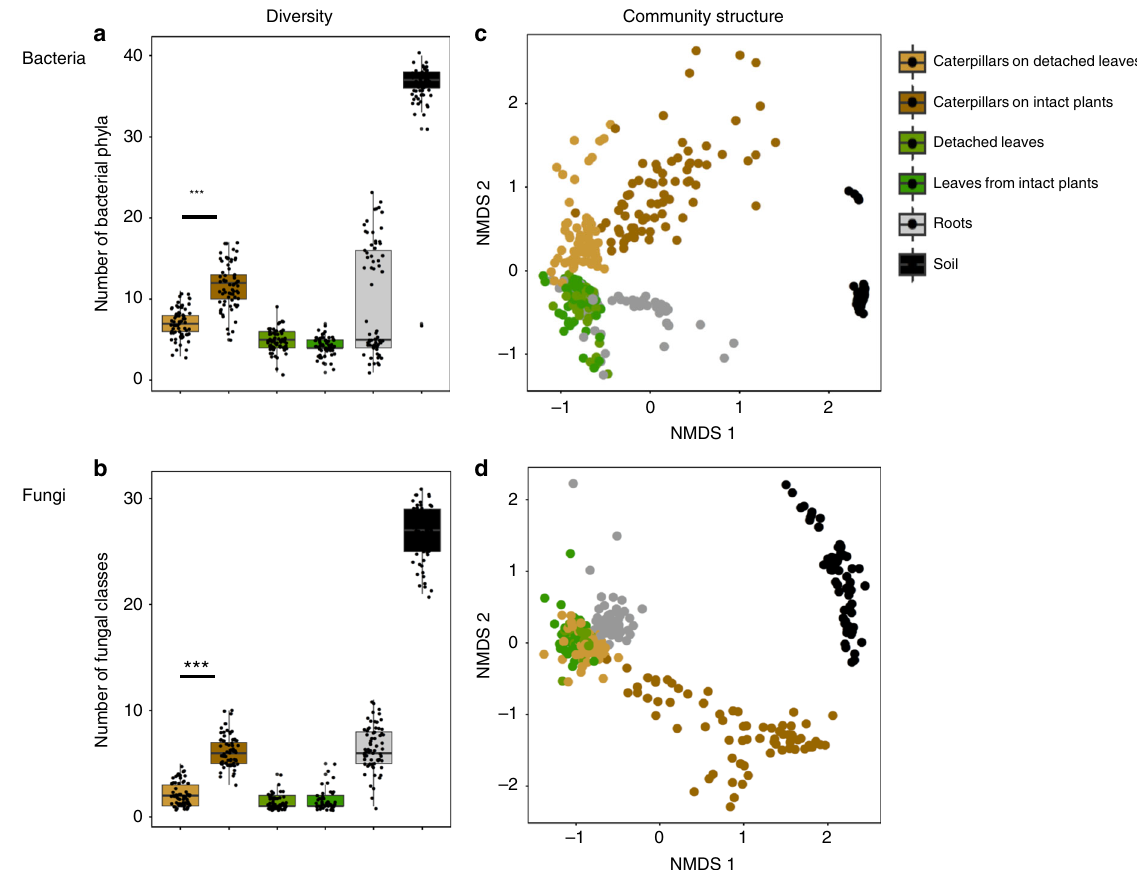
Fig. 1 Diversity and community structure of bacteria and fungi in caterpillars, leaves, roots and soil. a number of bacterial phyla and b number of fungal classes of caterpillar, leaf, root and soil samples. Caterpillars were kept on intact plants or on detached leaves. The Tukey box-and-whisker-plots depict median number of phyla and classes in each compartment and variation is shown in the scatter. The raw (Chao1) diversity data is presented in Supplementary Fig. 2, and phyla and their relative abundance in Supplementary Fig. 3 (bacteria) and Supplementary Fig. 4 (fungi). Asterisks (***) indicate signi fi cant differences of GLM at the level of p < 0.001. c , d Non-metric multidimensional scaling (NMDS) of bacterial ( c ) and fungal ( d ) communities. The clustering is based on Bray-Curtis similarity and the resulting 2D stress for the best solution is 0.16 (bacteria) and 0.19 (fungi). Source data for a and b